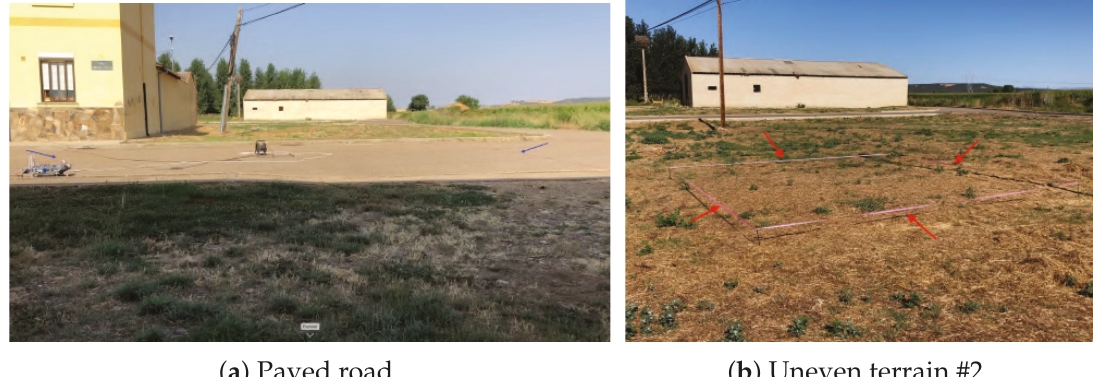
Figure 32. Outdoor test #2